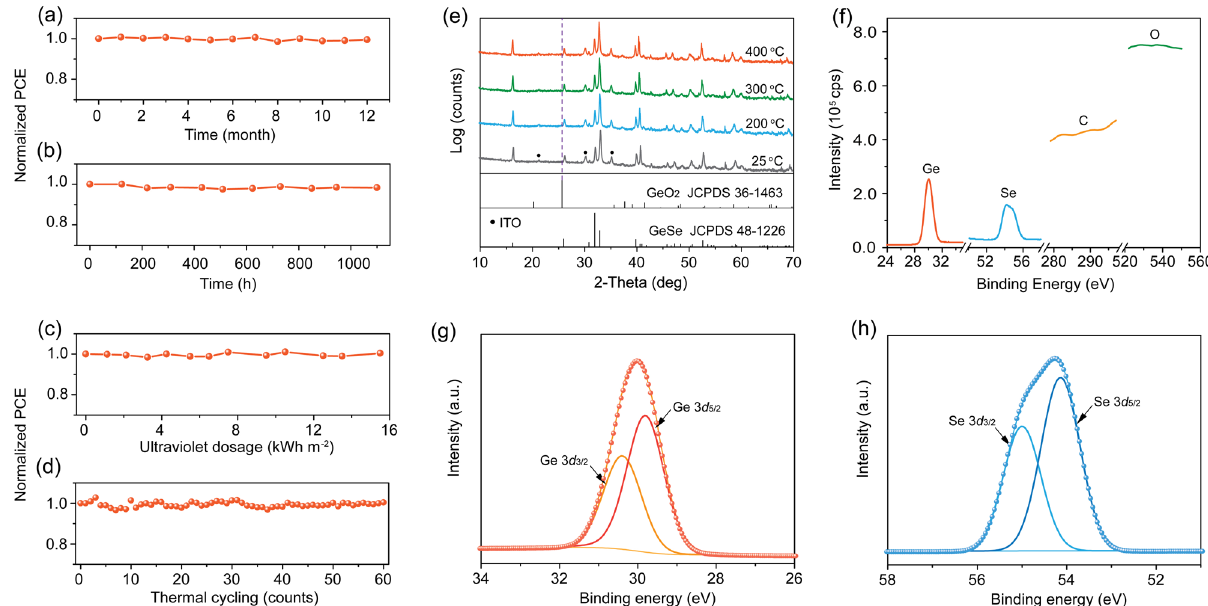
Fig. 4 Device and materials stability. a Long-term stability (ambient atmosphere, room temperature, relative humidity of 50 – 85%), b operational stability (ambient atmosphere, continuous 1-sun illumination, close to maximum power point), c ultraviolet photostability (200 – 400 nm ultraviolet light irradiation), and d thermal cycling stability (cycling between − 40 to 85 °C for 60 cycles) of unencapsulated GeSe devices. e Temperature-dependent XRD patterns of GeSe fi lm from 25 to 400 °C in ambient atmosphere. XPS spectra of f Ge, Se, C, and O, g Ge 3 d , and h Se 3 d in the GeSe fi lm after temperature-dependent XRD